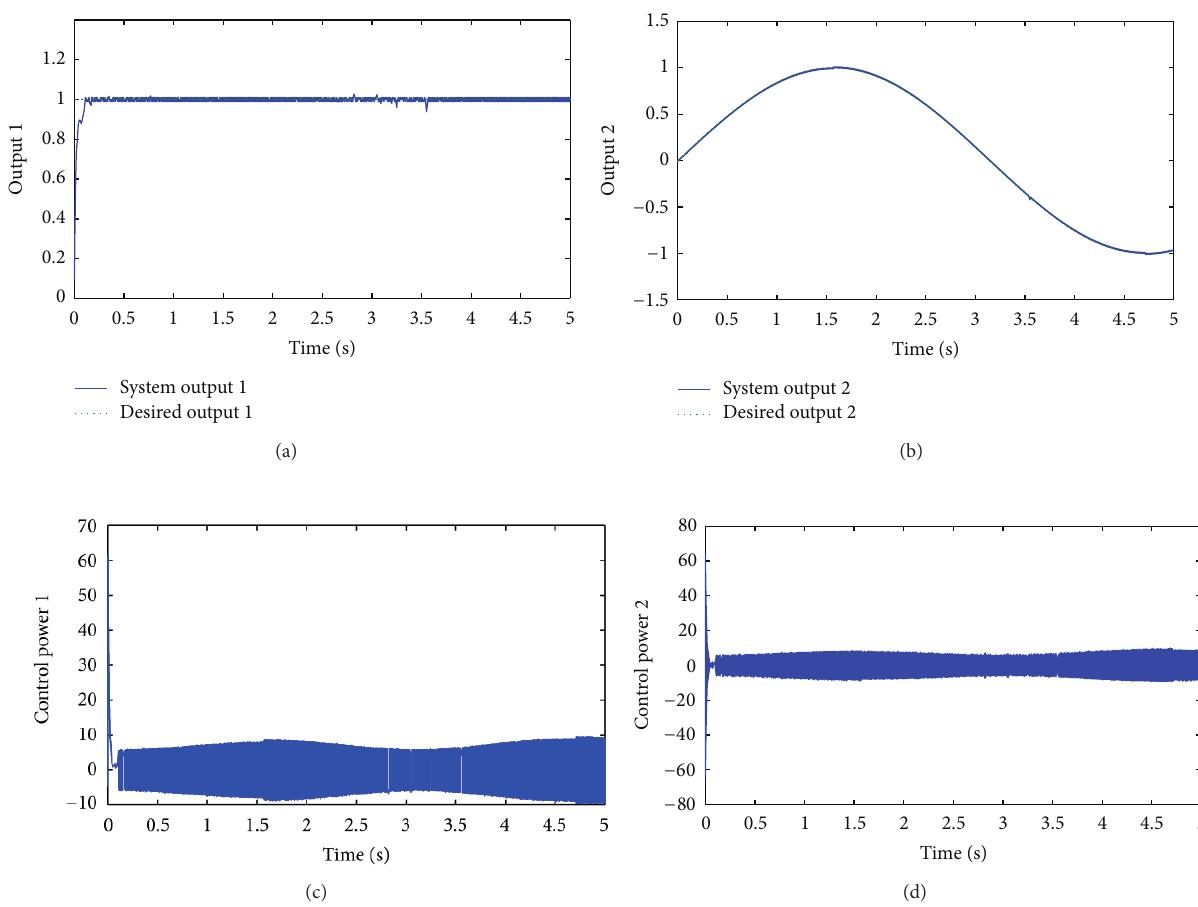
Figure 2: Simulation results for MIMO system with disturbance. (a), (b) system outputs 1 and 2. (c), (d) control signals 𝑢 relative to inputs 1 and